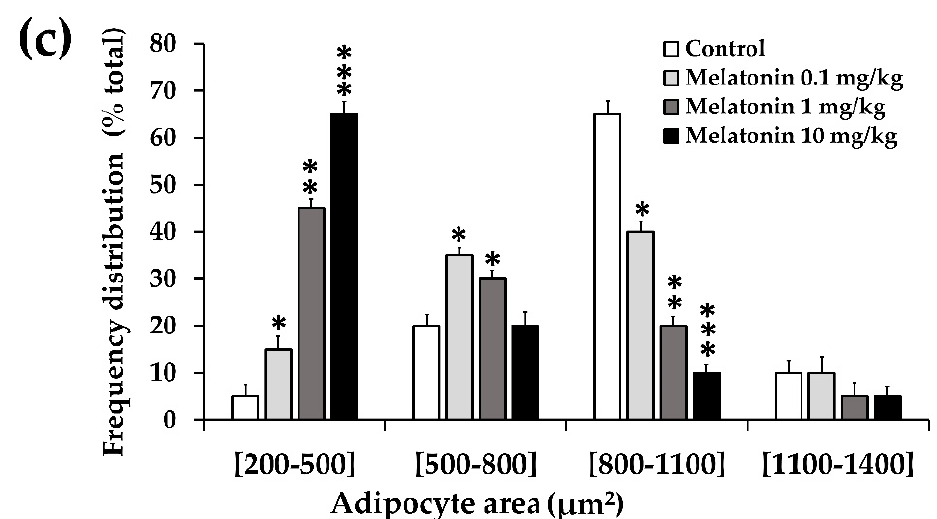
Figure 2. Dose-dependent effects of melatonin on iBAT morphology in Zücker diabetic fatty rats. ( a ) Representative haematoxylin and eosin staining of iBAT sections (original magnification ×400). ( b , c ) Mean adipocyte area ( b ) and frequency distribution of adipocyte area ( c ) were measured using a quantitative morphometric method with Image J software. Mel-0.1, Mel-1, and Mel-10: melatonin at a dose of 0.1, 1, and 10 mg/kg b.w, respectively. Values are means ± S.D ( n = 200 adipocytes/group). * p < 0.05, ** p < 0.01, *** p < 0.001 Mel-0.1, Mel-1, and Mel-10 vs. Control; # p < 0.05 Mel-10 vs. Mel-0.1; × p < 0.05 Mel-1 vs. Mel-0.1 (One-way ANOVA Tukey with post hoc test). Scale bar: 50 μ m.